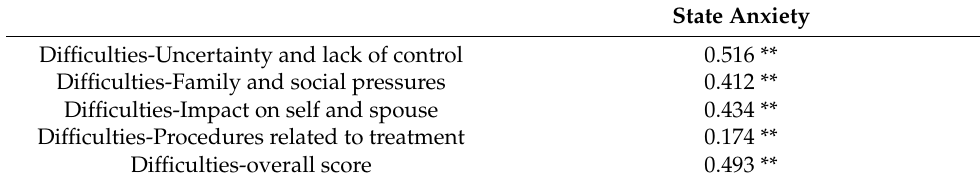
Table 4. Correlations between anxiety and difficulties of infertile